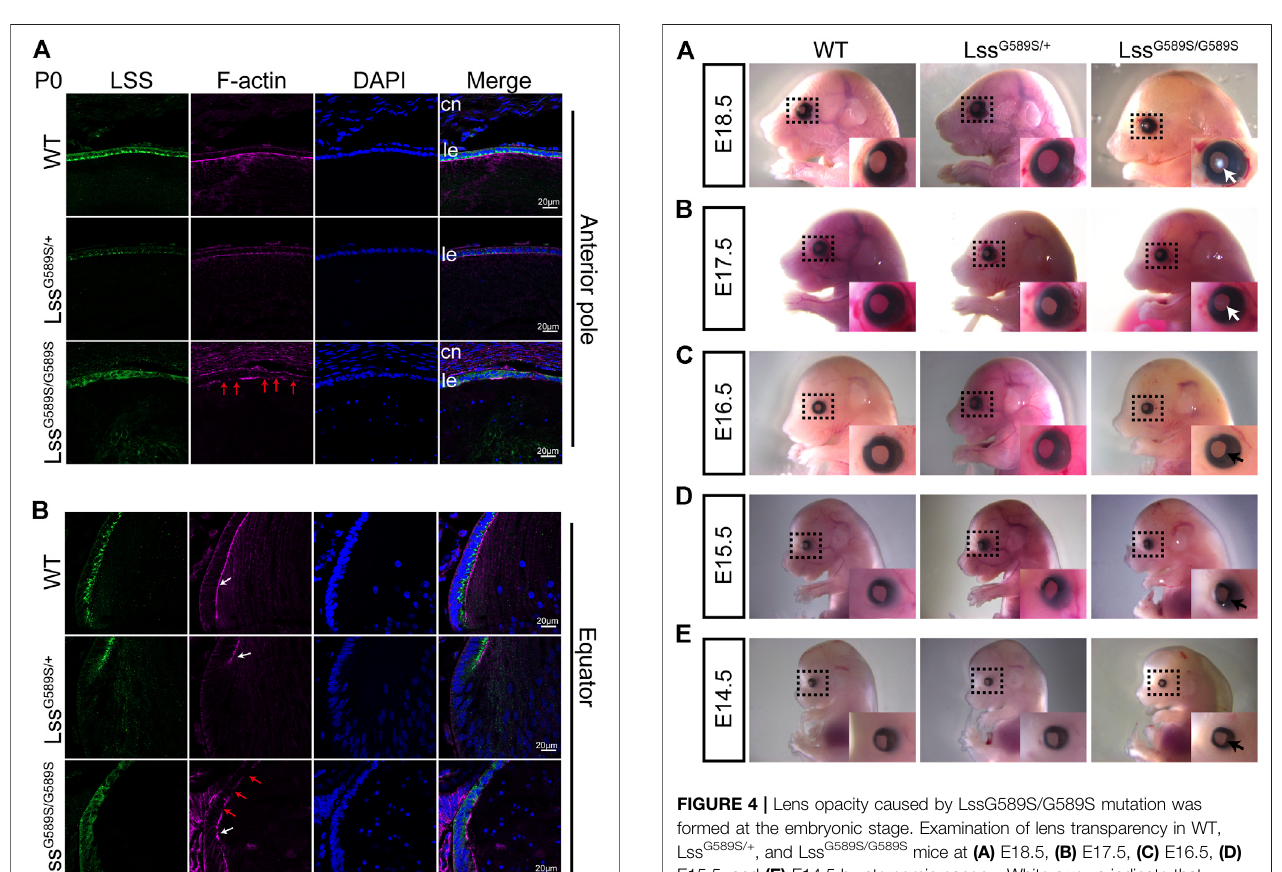
Supplementary Figure 2B , red triangle) and condensed nuclei ( Figure 2B , red arrows, Supplementary Figure 2B ) were observed in the central organelle-free zone (OFZ) of Lss G589S/G589S lens.